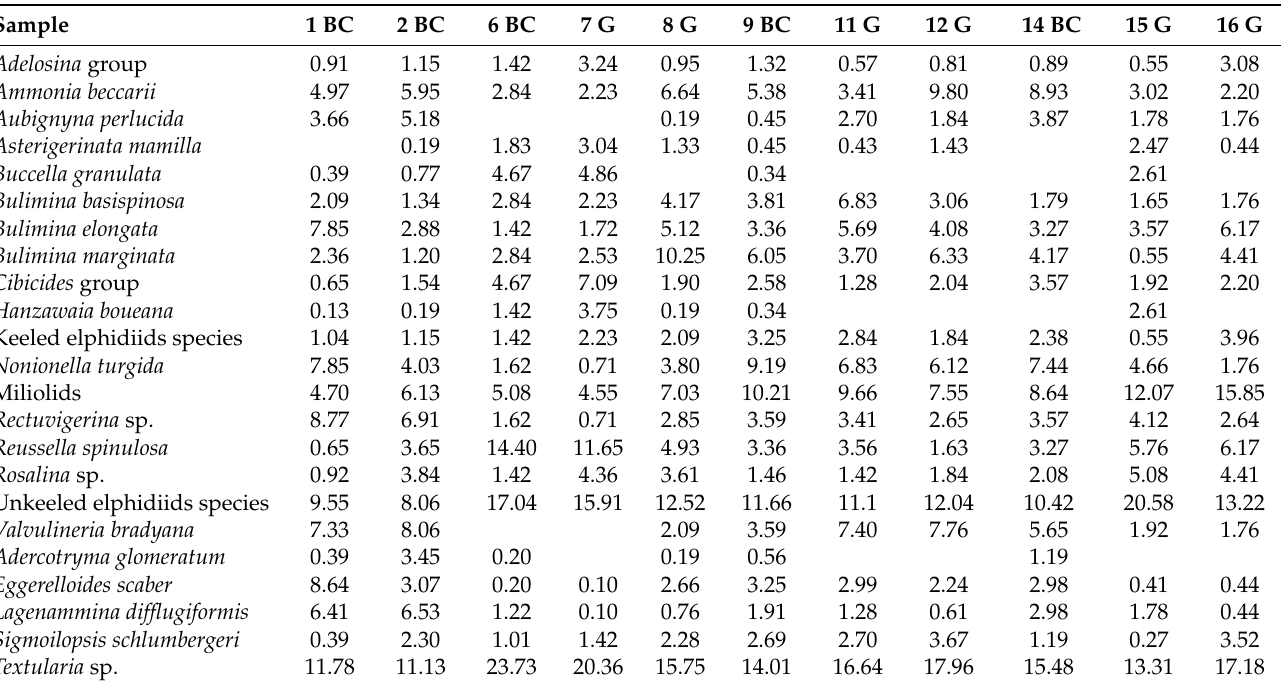
Table 2. Relative percentages of the most common species (>3% in at least one sample) identified in the surface sediment layer (0–2